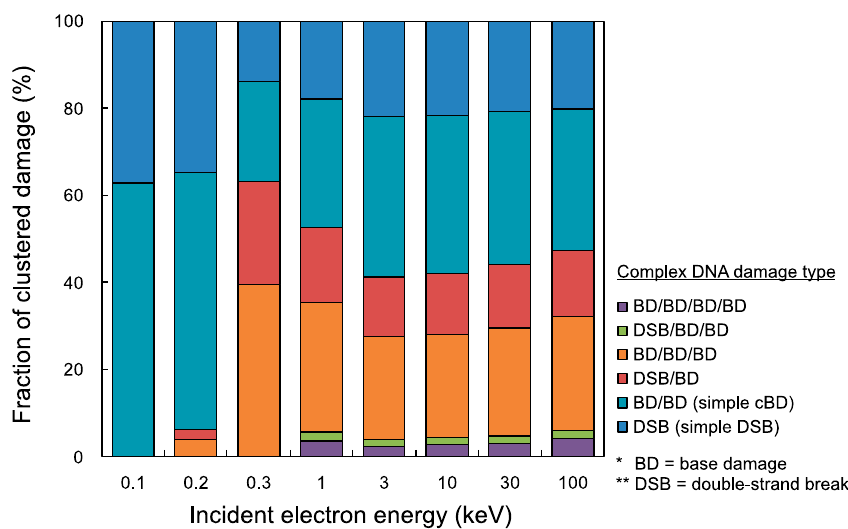
Figure 4. Fractions of cluster DNA damage yields for mono-energetic electron. The blue bar graph is simple double-strand break (DSB), light blue is simple complex base damage (cBD) as BD / BD, red is DSB / BD, orange is BD / BD / BD, green is DSB / BD / BD, and purple is BD / BD / BD / BD. It should be noted that the maximum inter-lesion distance and detection efficiency η were set as 10 bp and 1.0, respectively.